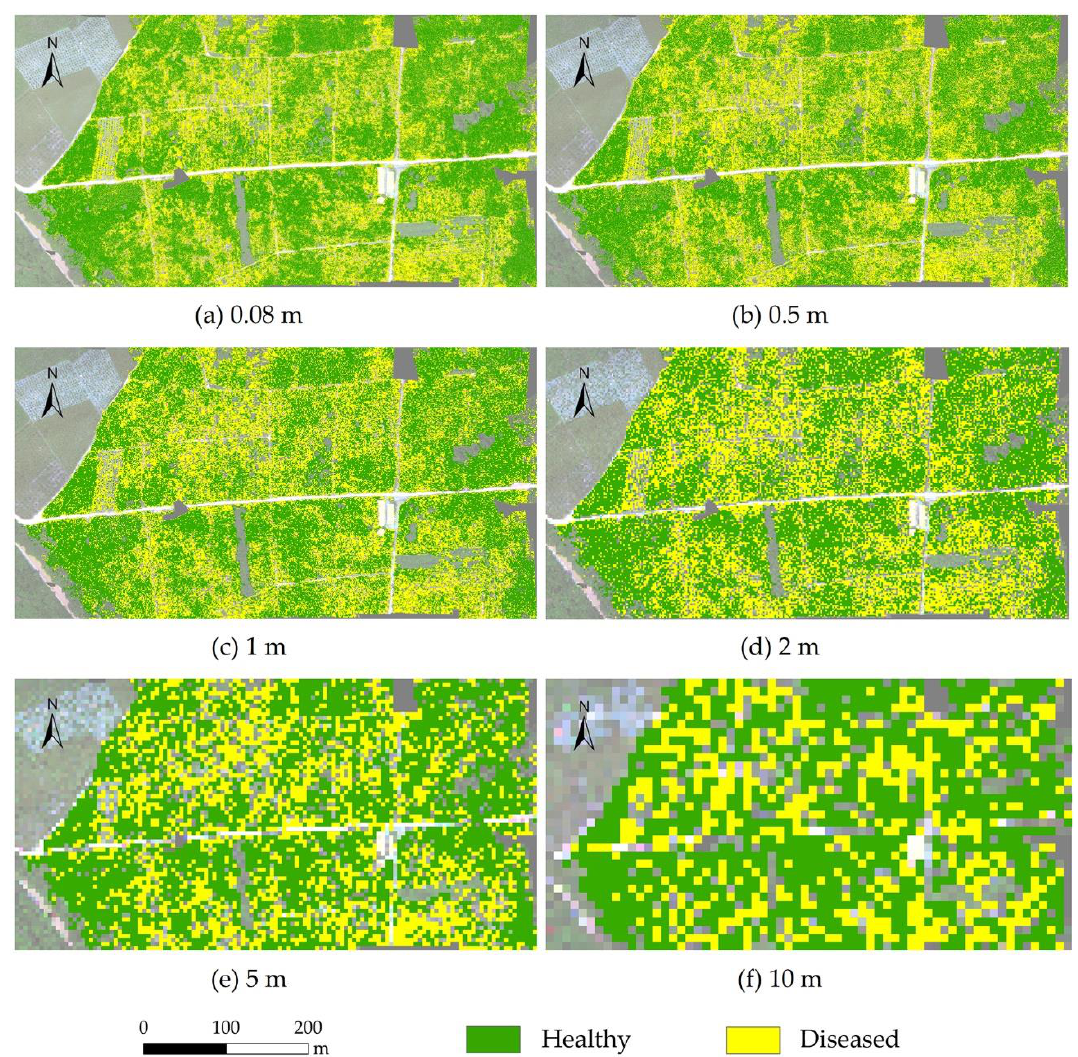
Figure 3. Maps of the distribution of banana Fusarium wilt at Guangxi site based on the CI green for di ff erent resolutions. ( a ) 0.08-m resolution; ( b ) 0.5-m resolution; ( c ) 1-m resolution; ( d ) 2-m resolution; ( e ) 5-m resolution; ( f ) 10-m resolution. Table 5. Area and percentage of the Fusarium wilt infected regions based on different resolution maps.